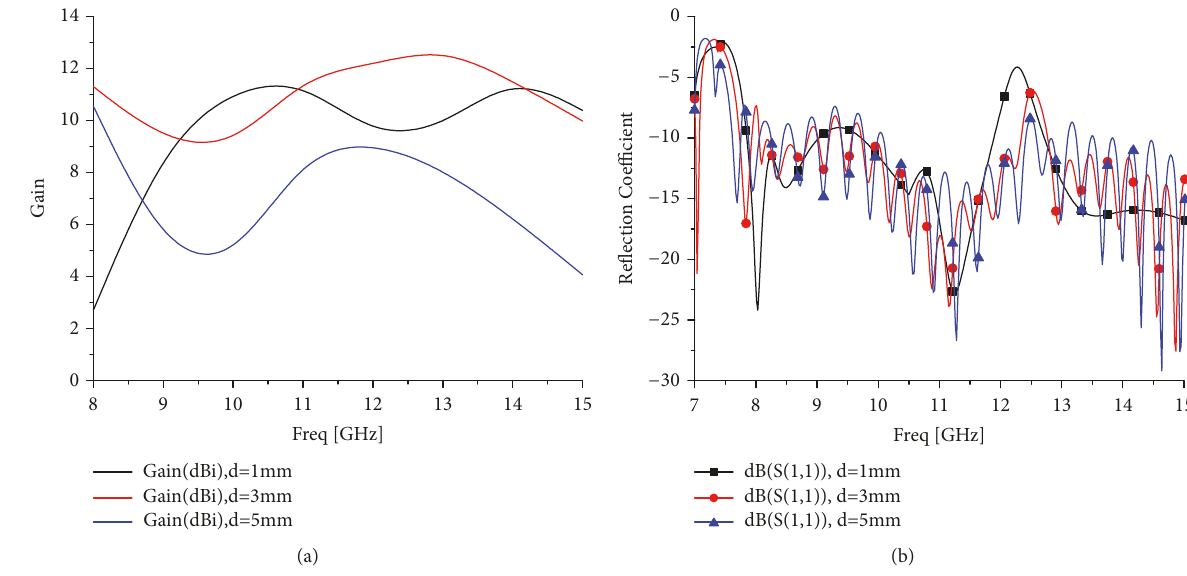
Figure 13: Influence of D on proposed antenna gain and reflection coefficient: (a) gain and (b) reflection